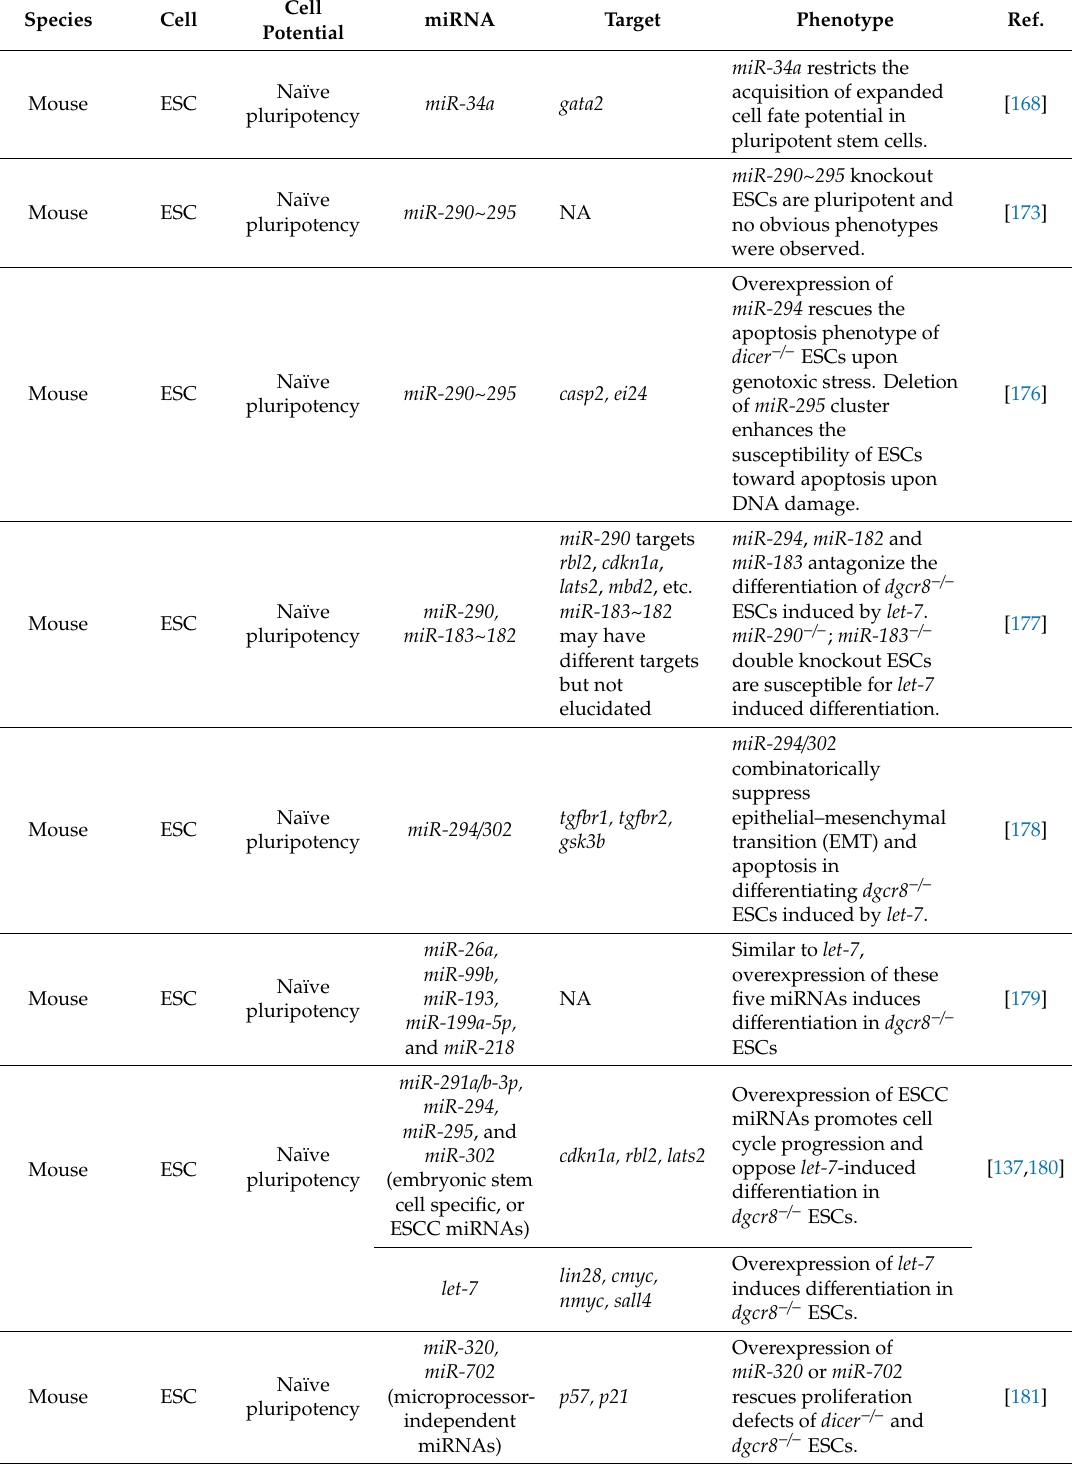
Table 2. Studies of specific miRNAs in in vitro cell culture